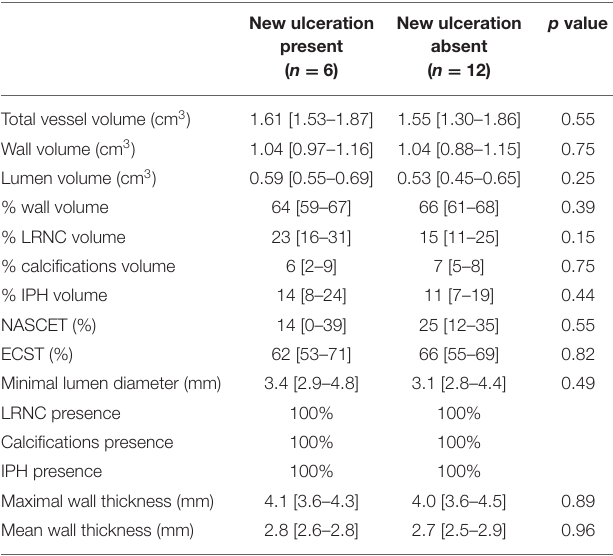
TABLE 1 | Plaque characteristics in the symptomatic carotid artery with (cases) and without (controls) new ulcerations at follow-up.